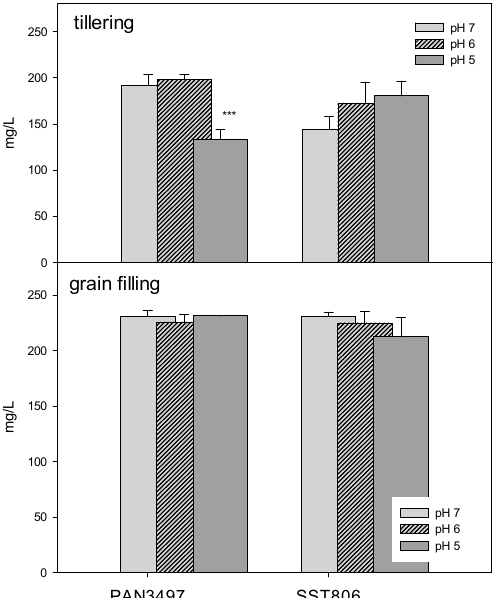
Figure 5. Protein content in leaves of PAN3497 and SST806 grown at three soil pH levels (pH 7, 6, and 5), with two sampling times (tillering and grain filling). Each value is the mean ± standard error of three biological and technical replicates. Significant difference compared to pH 7: *** p < 0.001.